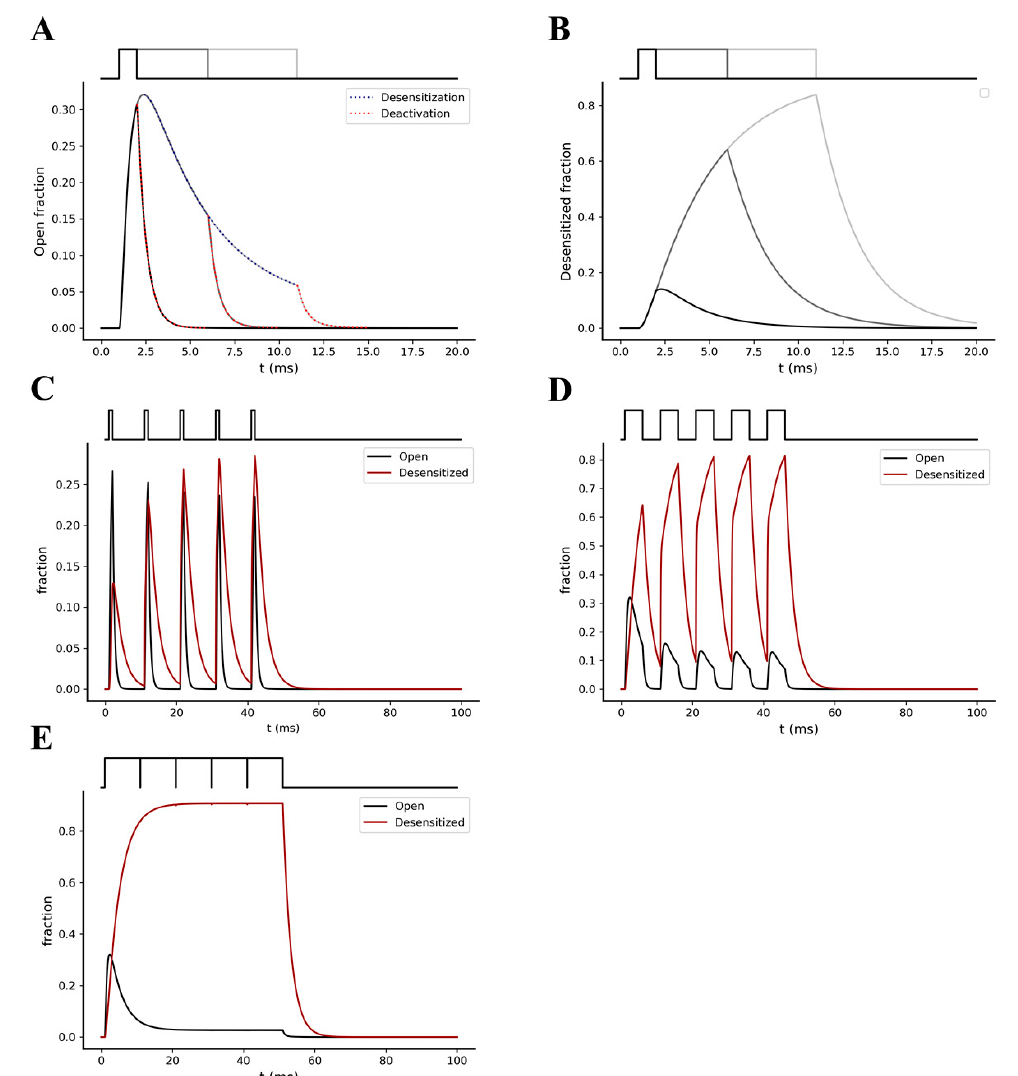
Figure 3. Opening and desensitization kinetics of the AMPA receptors. ( A ) Open fraction kinetics following a stimulation with a single glutamate pulse of 1 mM amplitude and width of 1 ms (black), 5 ms (dark grey) and 10 ms (light grey). Blue dotted trace shows the desensitization kinetics, while red dotted traces show the deactivation kinetics following glutamate removal from the synaptic cleft. ( B ) Desensitized fraction kinetics following a stimulation with a single glutamate pulse of 1 mM amplitude and width of 1 ms (black), 5 ms (dark grey), and 10 ms (light grey). ( C – E ) Kinetics of open and desensitized fractions following pre-synaptic stimulations with a burst composed of 5 glutamate pulses, with glutamate pulse amplitude of 1 mM, an intra-burst frequency of 100 Hz, and a pulses width of 1 ms ( C ), 5 ms ( D ), and 10 ms ( E ).